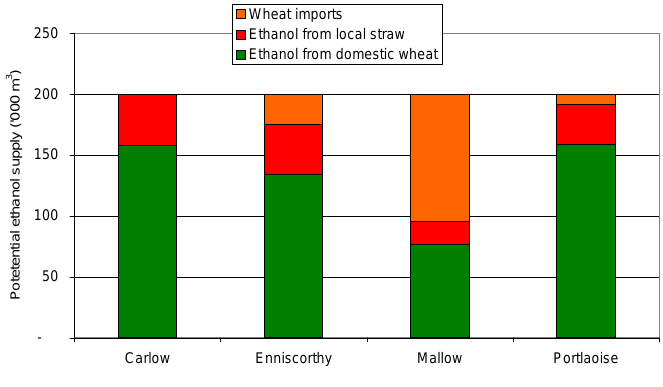
Figure 7. Modeled production of ethanol from the potential feedstock of domestic wheat and straw and required imports for inland